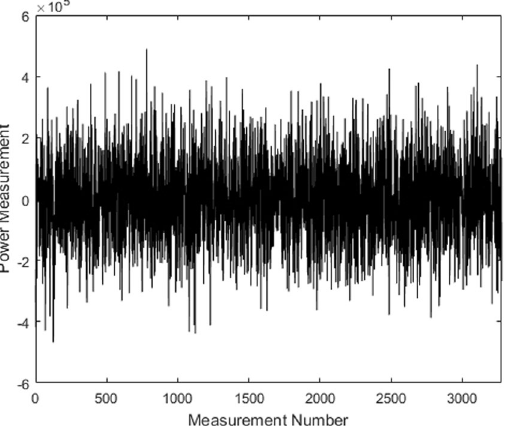
Figure 3. Typical measurement result y for a 20% measurement rate. The average value is zero due to the balanced sensing matrix A . Fluctuations around zero determine which sparse elements in x are significant. The results appear random due to A being incoherent with x